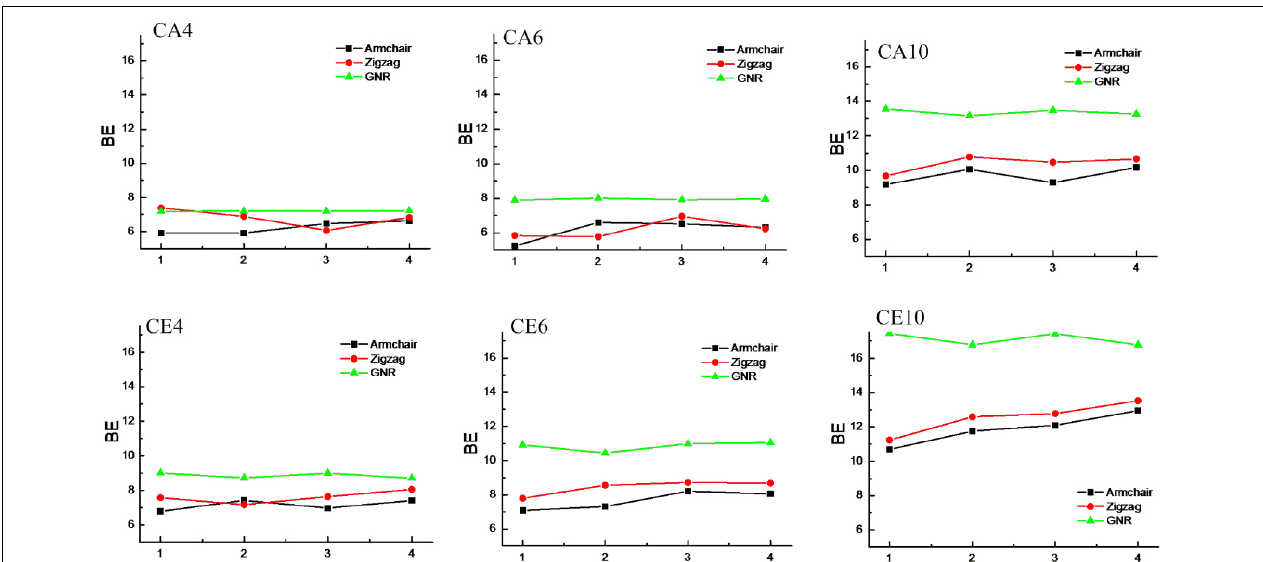
FIGURE 9 | Effect of curvature and chirality on the binding affinity of cyclic hydrocarbons with CNSs.